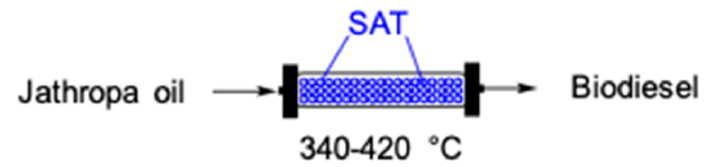
Figure 13. Schematic diagram of lab scale fixed bed reactor. Table 14. Experimental results of Jatropha oil cracking over SAT